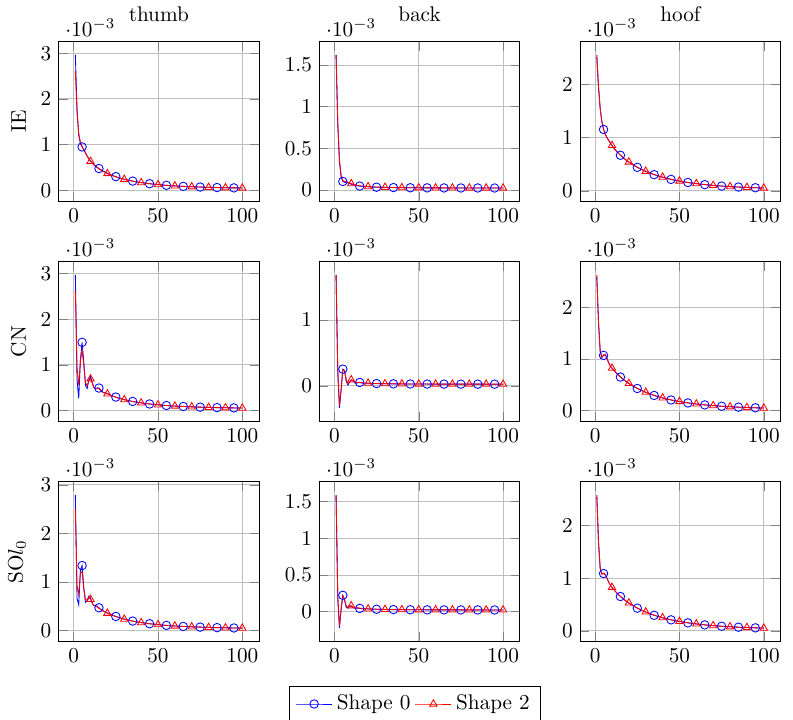
Figure 14. The comparison of the feature descriptors from the centaur shape. We used the damped wave equation ( k = 0.1) with the δ -peak initial condition to generate the feature descriptor. Shape 0, Shape 2 and the points are equal to the points, and shapes shown in Figure 1. ( Rows ) Different solvers. ( Columns ) Different